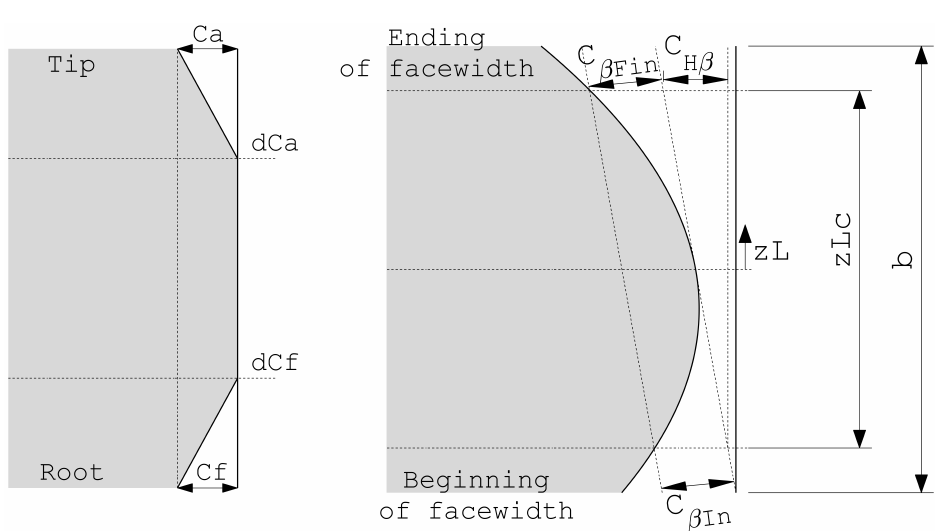
Figure 1. Nomenclature of different TPM. ( left ) Tip and root relief modifications, ( right ) TPM along the face-width.